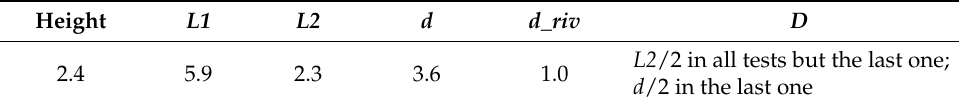
Figure 3. Test chamber: nozzles and heat detector. Table 1. Geometry of the test chamber: design parameters (dimensions are in m).